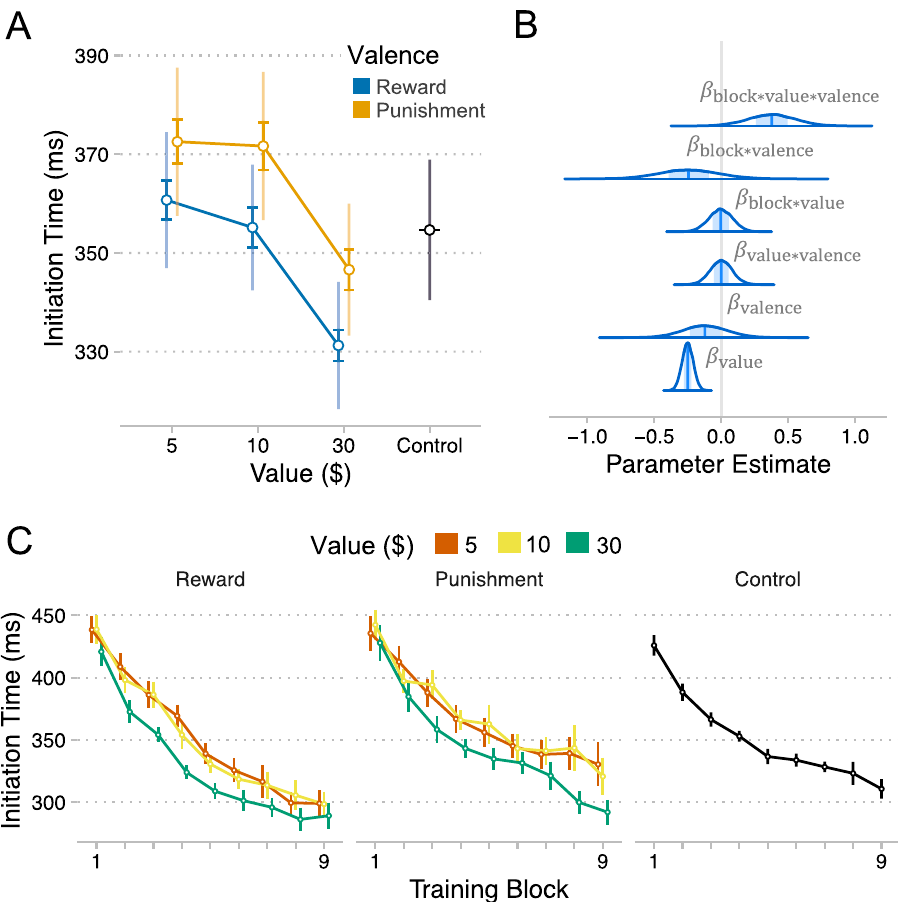
Figure 4. Effects of training incentives on movement initiation. ( A ) Initiation RT (mean + /- se) for each level of value by valence. The bold error bars represent within-subject standard error (for value effect) and the non- bold error bars are between-subject standard error (for valence effect). ( B ) Densities of MCMC samples used to approximate posterior probability distributions over key regression coefficients. ( C ) Initial RT for each level of block by value (sequence) by valence (group). Plots were created using ggplot2 46